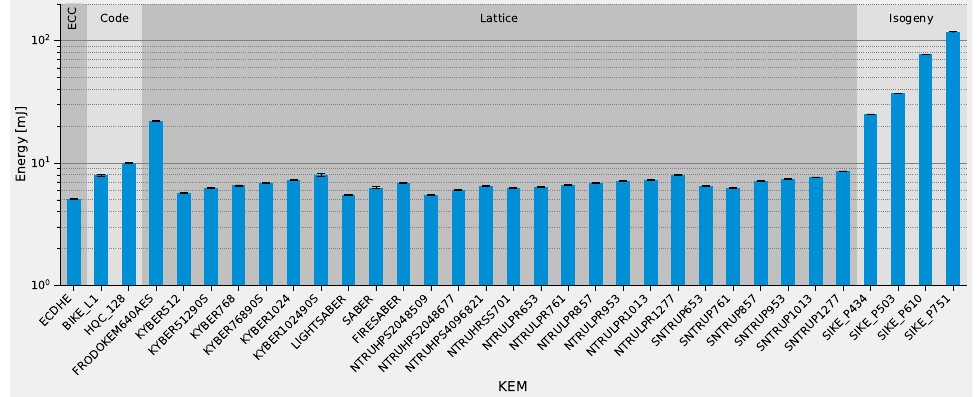
Figure 8. TLS 1.2 handshake energy for all NIST Round 3 KEMs with 20ms BLE connection interval.